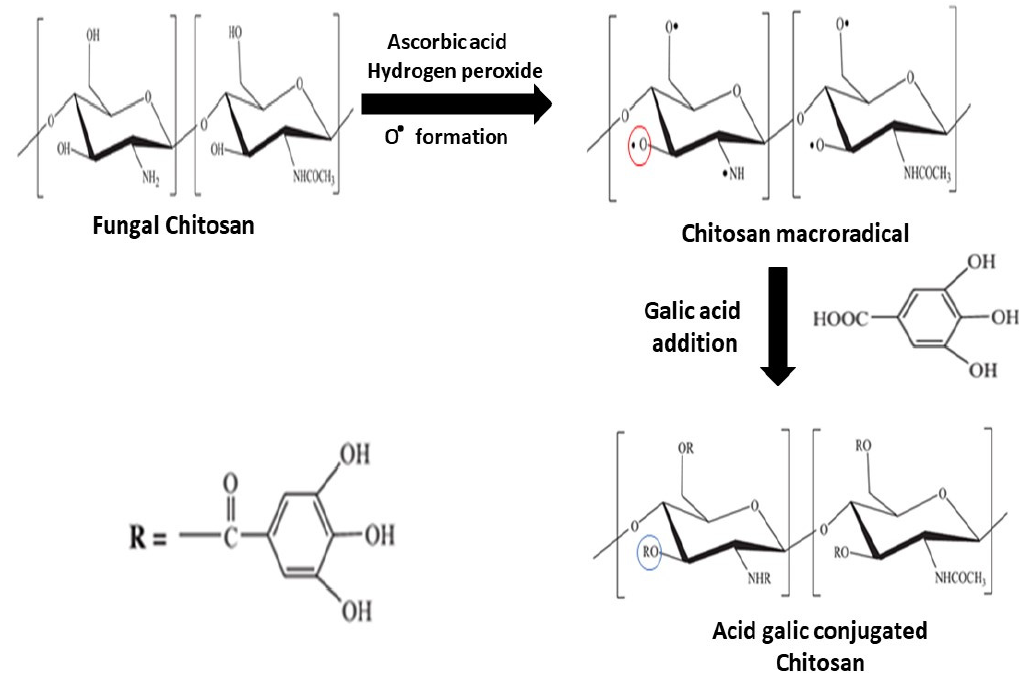
Figure 2. Scheme of the conjugation process of gallic acid (GA) and fungal chitosan (Chit-F). Step 1 is the addition of the redox pair and the formation of macroradicals. The red circle shows the radical. Step 2 is the addition of GA to the solution and the formation of the conjugated molecule. The blue circle shows the position of linked gallic acid. R—GA or hydrogen.